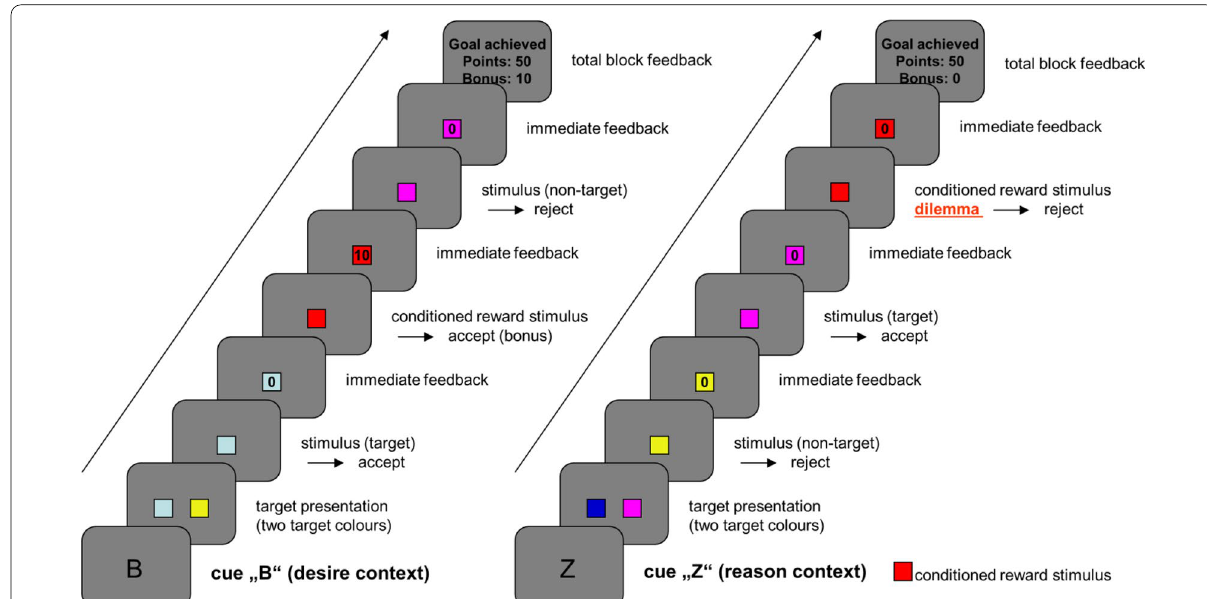
Fig. 2 Graphical depiction of the DRD task. Subjects got first presented the cue (either the desire context (left) or the reason context (right)) and then had to react on the shown colors as priory